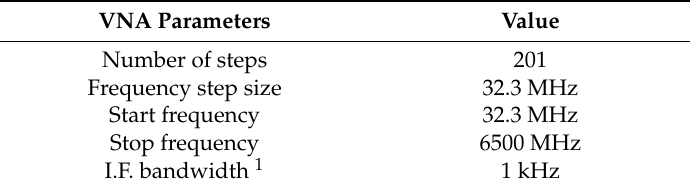
Table 2. Summary of the key vector network analyser (VNA) parameters used.